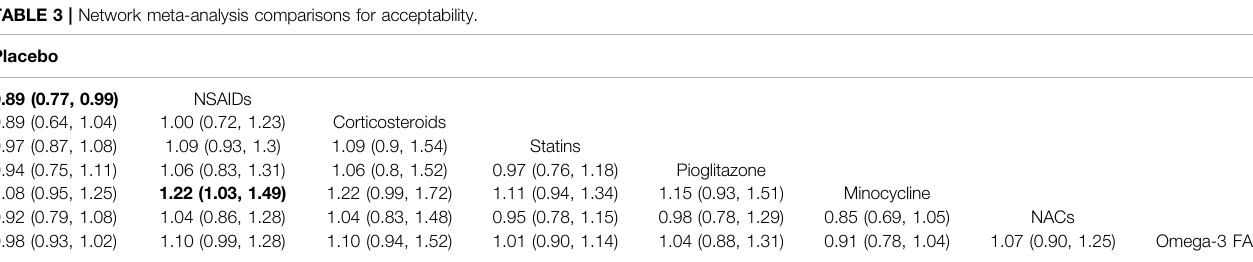
TABLE 3 | Network meta-analysis comparisons for acceptability. Placebo